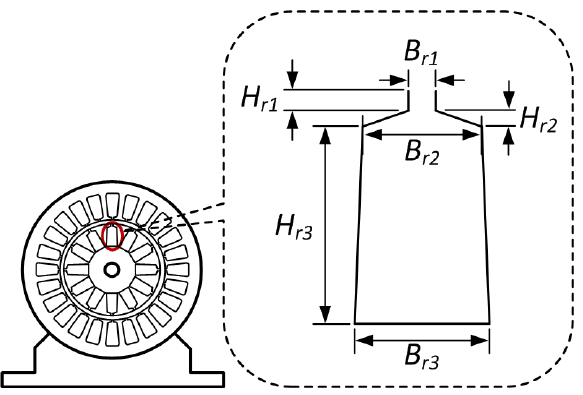
Figure 3. Rotor slot shape of induction motor and its